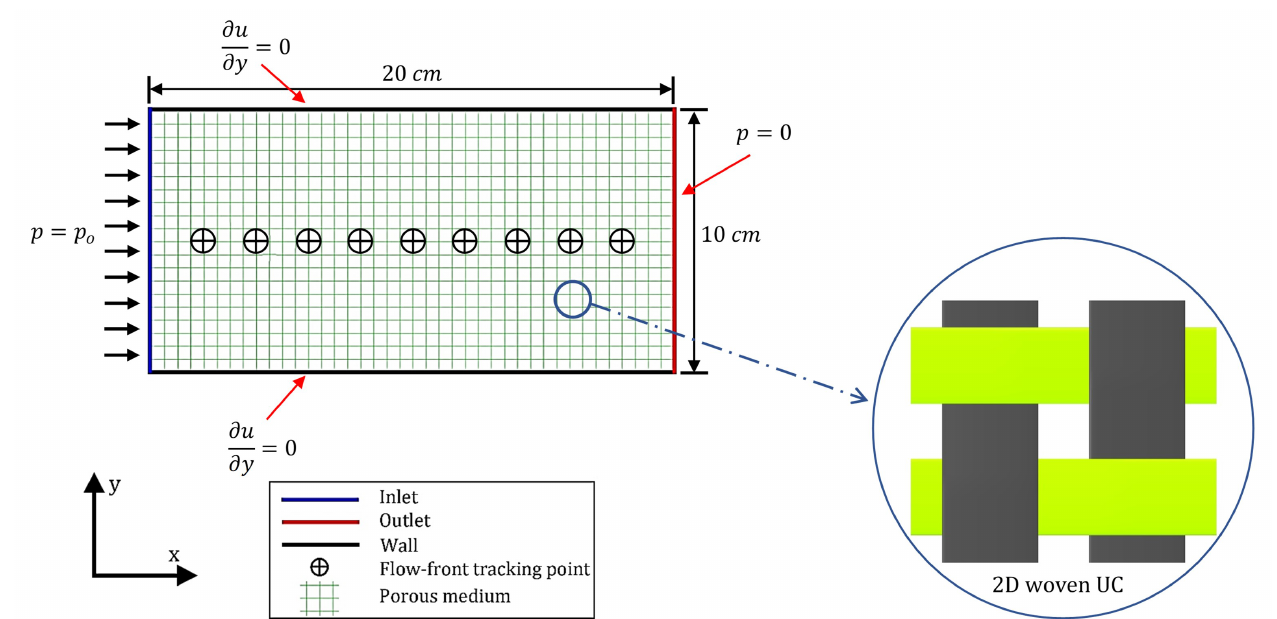
Figure 3. Geometry and boundary conditions used in the numerical simulation, including flow-front tracking